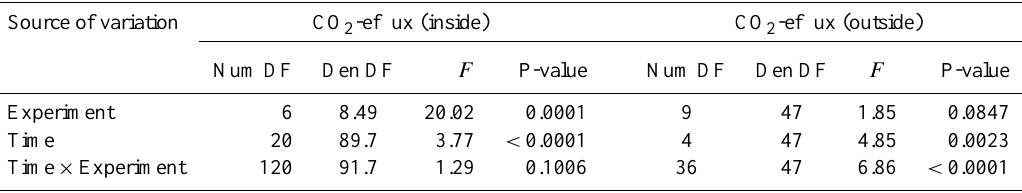
Table 3. Repeated measures ANOVA of CO 2 -efflux for the period inside the laboratory (left: analysis of WSR, DSR and control soil cores during 56 days of measurements) and outside the laboratory (right: analysis of WSR, DSR, MR and control soil cores during 21 days of measurements). (Num DF: Numerator degrees of freedom; Den DF: denominator degrees of